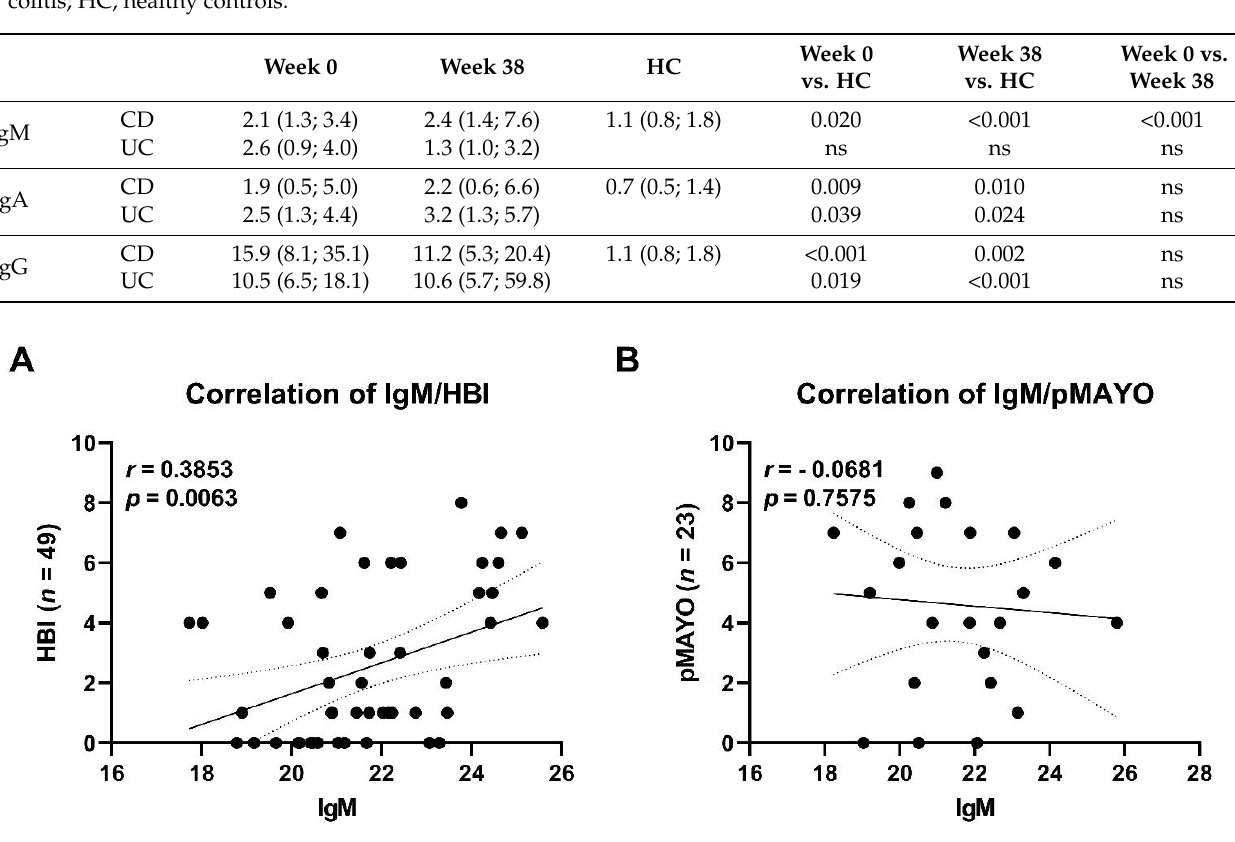
Figure 8. Correlation of total IgM serum levels and disease severity in patients with Crohn’s disease ( A ) and patients with ulcerative colitis ( B ). Each dot represents a sample from a patient at a specific time point. Trendline (bold line) including confidence interval (dotted line) is shown. Abbreviations: HBI, Harvey–Bradshaw index; pMayo, partial Mayo score; n, number of samples.